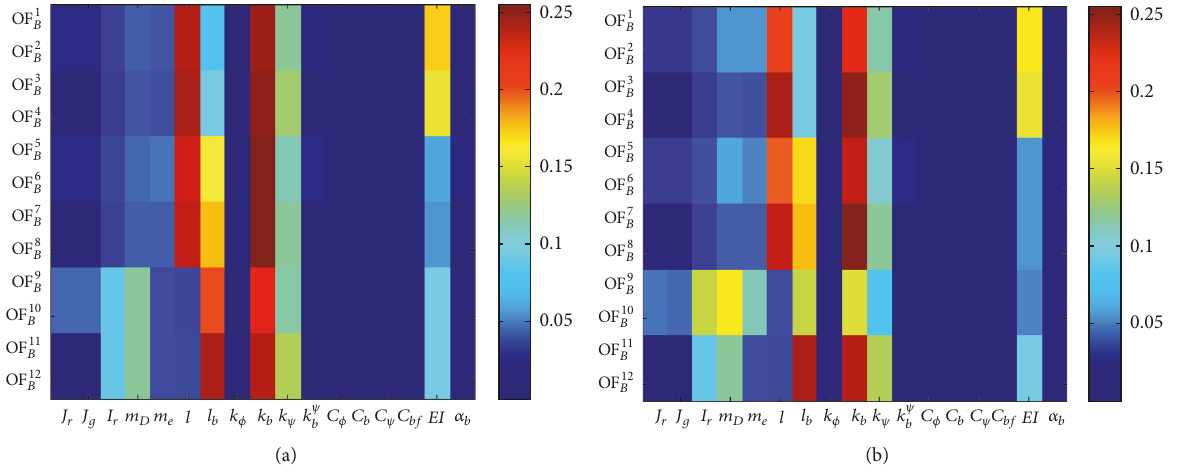
Figure 12: Primary sensitivity 𝑆 𝑖 (a) and total sensitivity ST 𝑖 (b) indices for bending model for OS 1,2,3 .